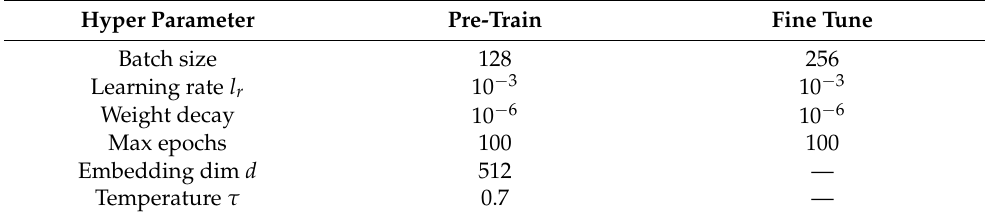
Table 4. SSCL model